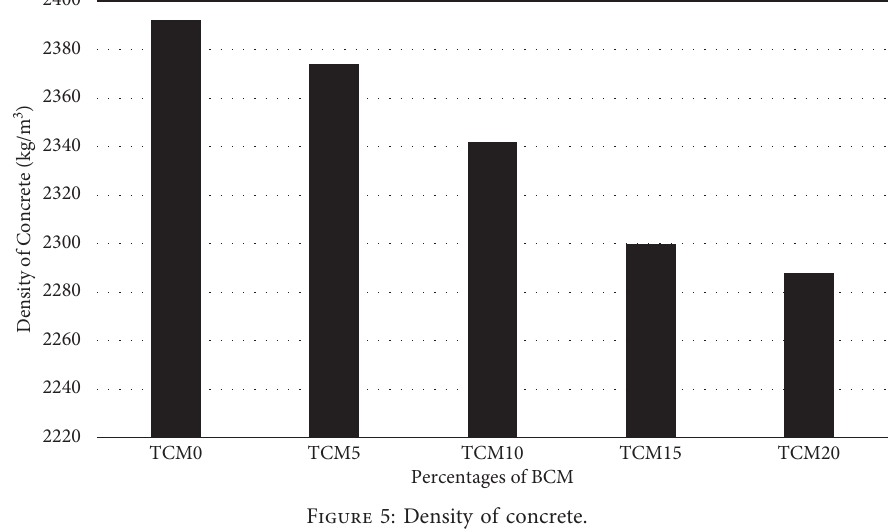
Figure 5: Density of concrete.